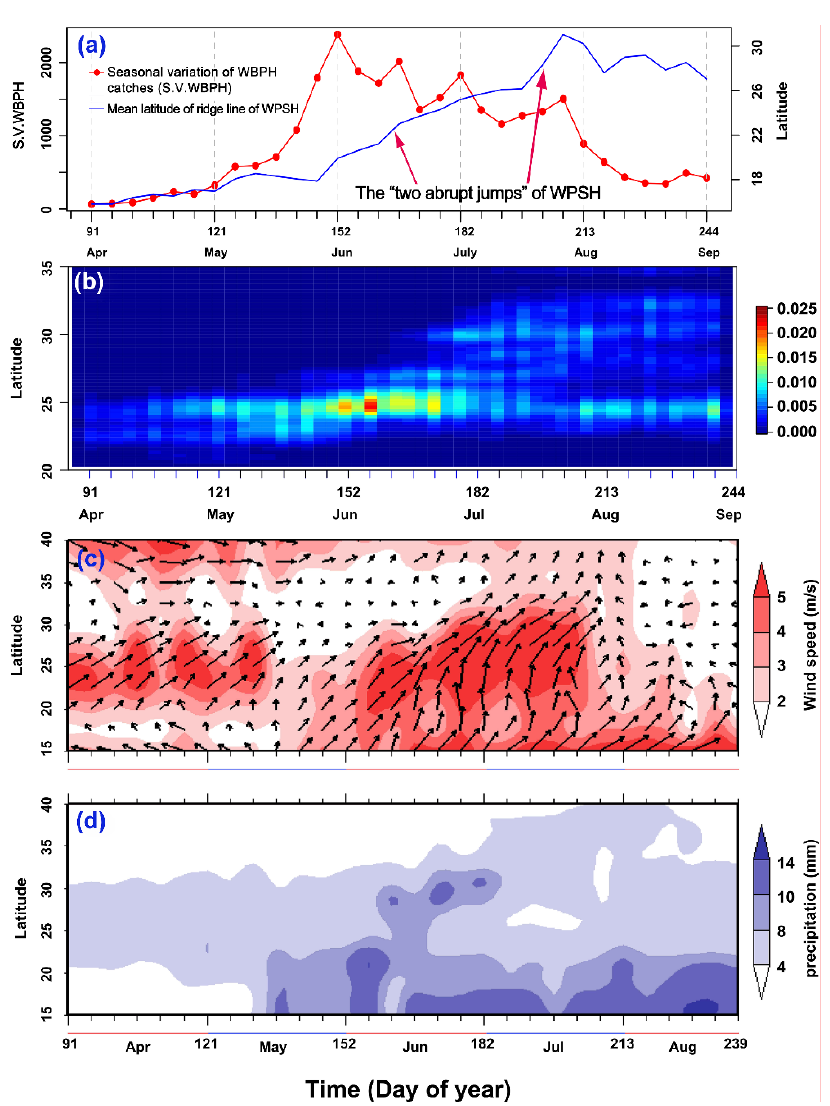
Figure 2. ( a ) The mean latitude of the WPSH ridge between 110° E and 120° E and the mean seasonal variation in 5-day WBPH catches in eastern China. The ‘two abrupt jumps’ of the WPSH are meteorologically defined (e.g., Tao & Wei 2006; Ding et al. 2007) [17,18] and denote the beginning and end of the Meiyu season in the Yangtze River Valley. ( b ) The location of the WBPH concentration zone in 5-day periods in eastern China, represented by the relative density of traps per unit of latitude for each 5-day period in a WBPH concentration zone. Any given WBPH trapping station in any 5-day period was defined as a planthopper ‘concentration zone’ if the number of WBPHs in the 5-day catch was greater than or equal to the WBPH90th (i.e., the 90th percentile value in that period of that year. ( c ) 27 year (1977 – 2003) mean winds at 850 hPa height in 5-day periods between 110° E and 120° E. ( d ) 27 year (1977 – 2003) mean precipitation in 5-day periods between 110° E and 120° E.